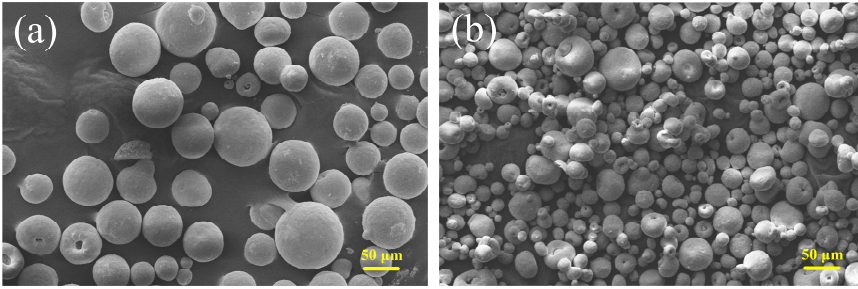
Figure 1. Particle sizes of the two batches 8YSZ powders. ( a ) 40–96 µm; ( b ) 15–55 µm.